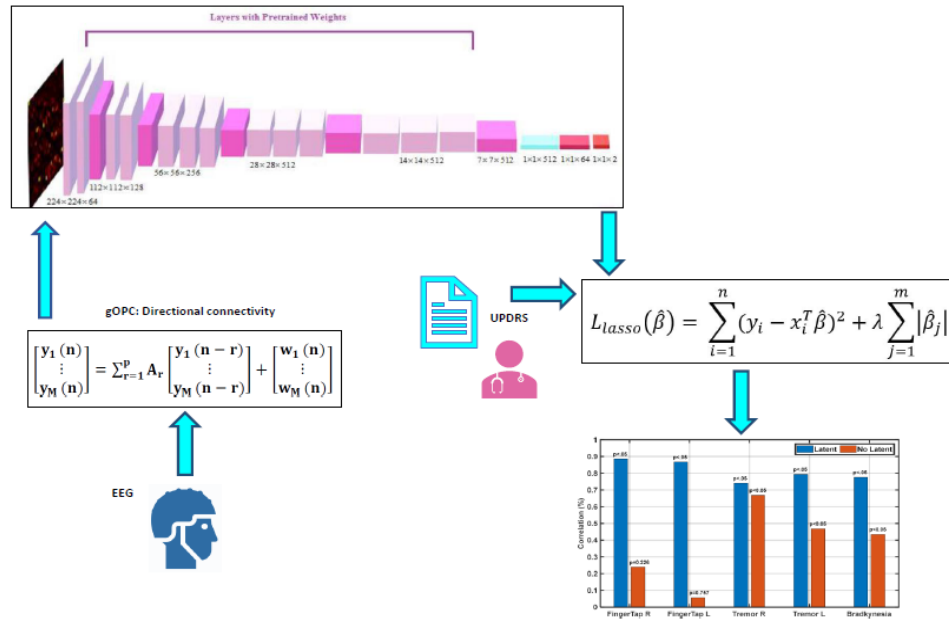
Figure 1. General schematic overview of the proposed approach.